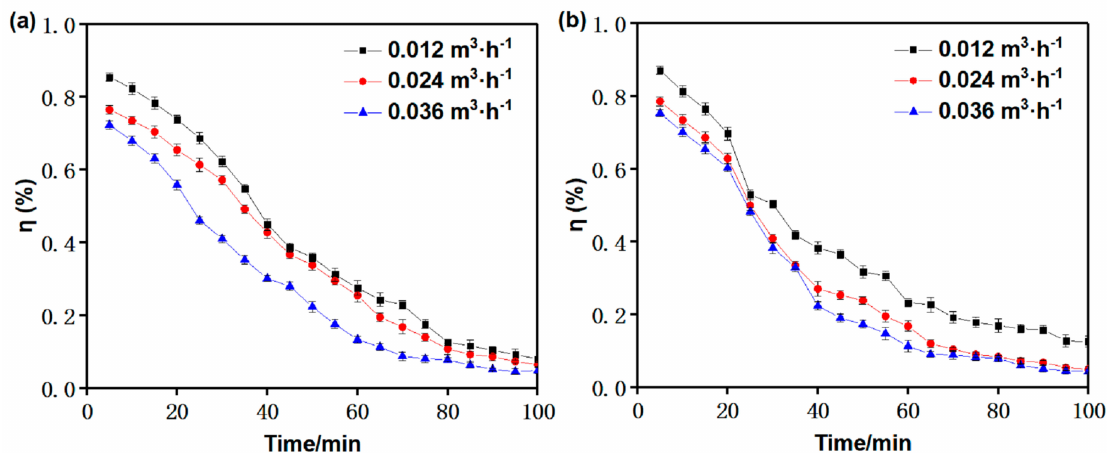
Figure 5. The influence of inlet gas flow on the absorptivity for ( a ) DCM and ( b ) benzene (C DCM = 20,000 mg · m − 3 , C Benzene = 5000 mg · m − 3 , 60 wt% [HMIM][Cl], T = 298.15 K).